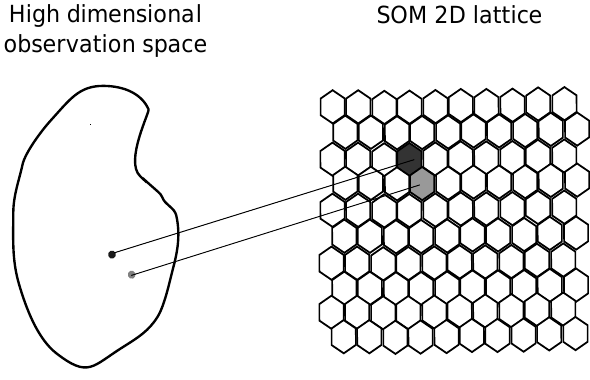
A sketch showing the geometry of the SOM two- dimensional lattice with 100 neurons and the correspondence be- tween SOM and the input space. Thanks to SOM’s topography preservation property, neurons associated with similar observations in the input space are close to each other on the